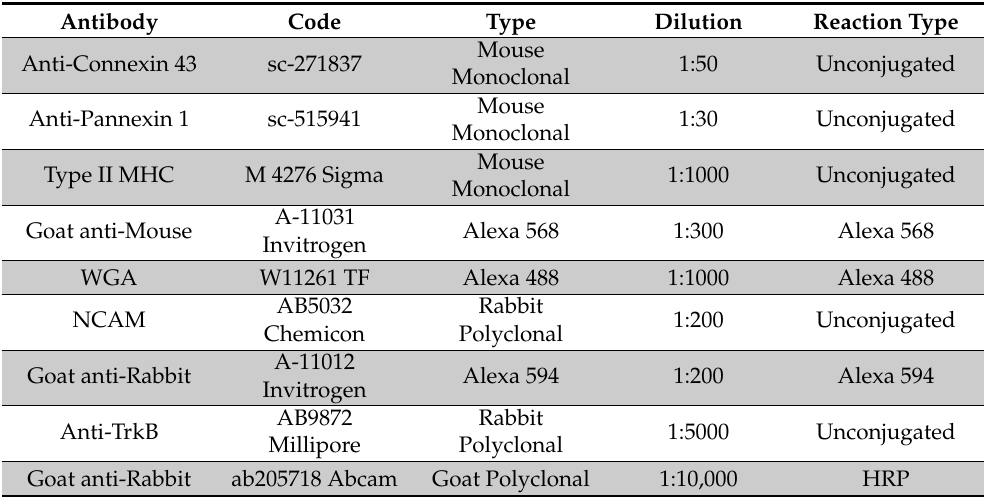
Table 1. Antibodies. The table includes primary and secondary antibodies, as well as dilutions, adopted in the